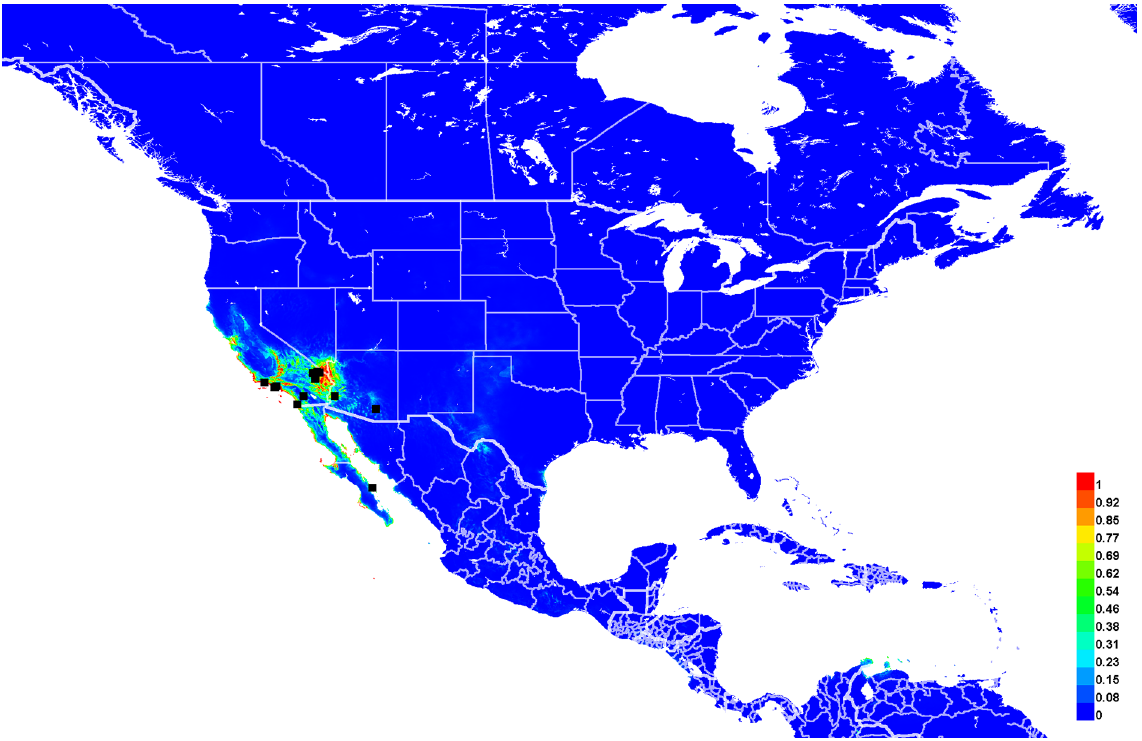
Fig. 73. Georeferenced collection records of Lasioglossum ( D. ) petrellum (Cockerell, 1903) (black squares) and predicted distribution by maximum entropy ecological niche modeling in Maxent (colour shading). Warmer colours indicate higher cloglog probability of